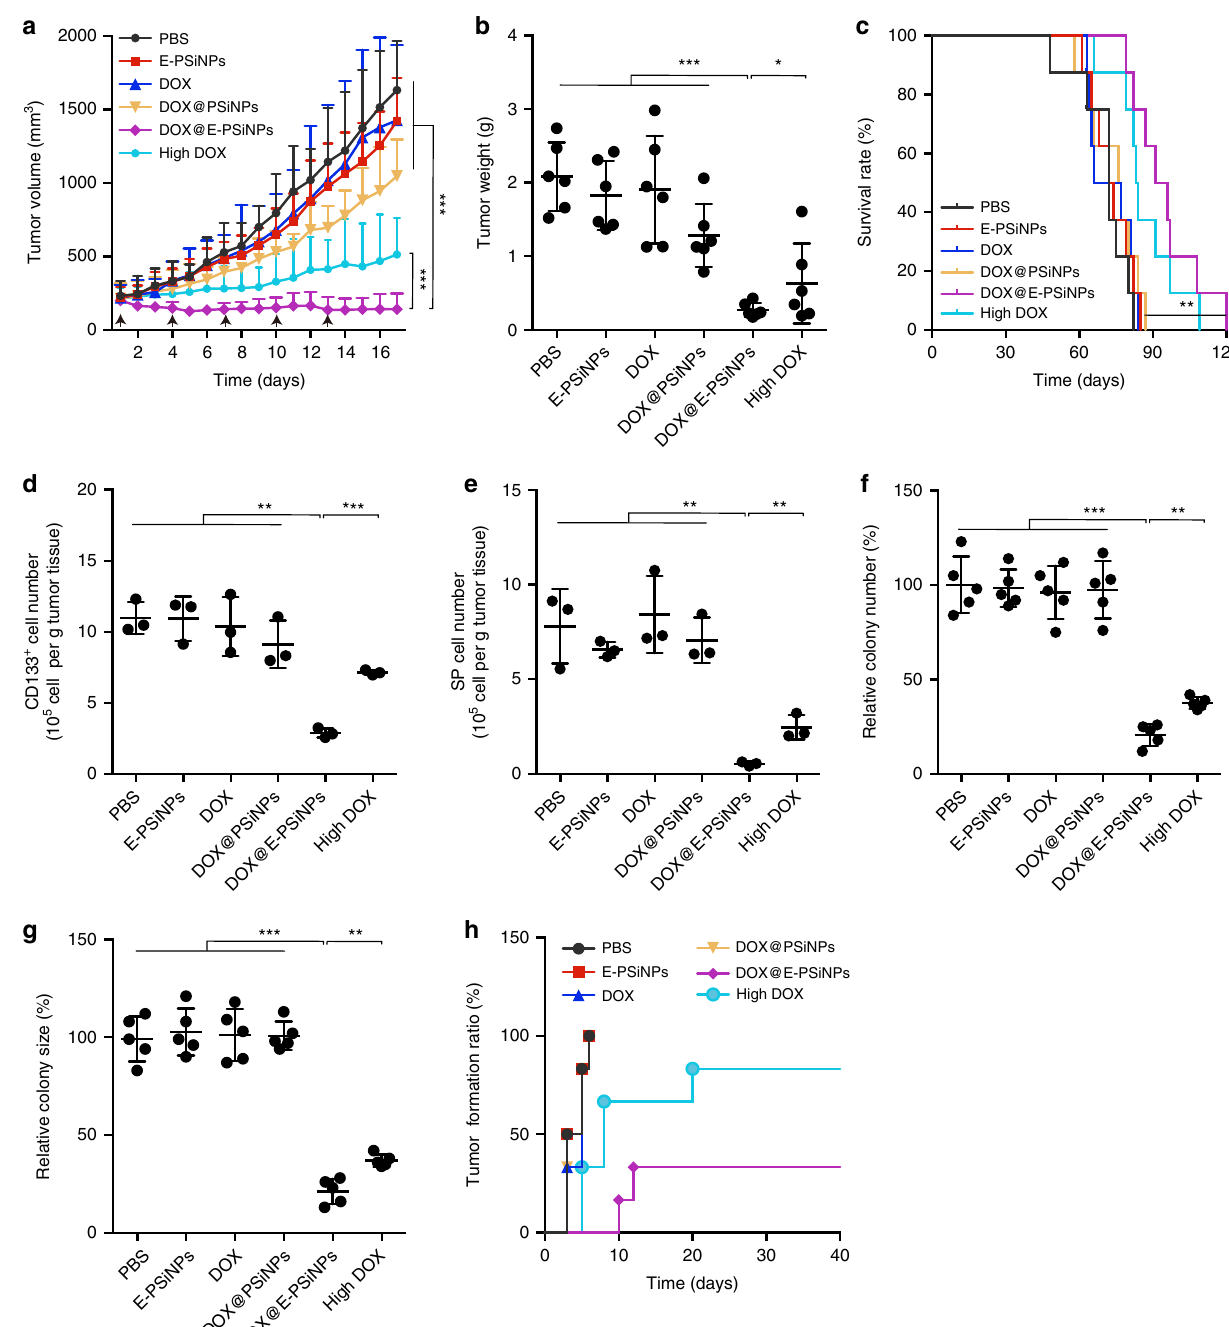
Fig. 7 Anticancer activity of DOX@E-PSiNPs in H22 tumor-bearing mice. a Tumor growth curves of H22 tumor-bearing mice after intravenous injection of PBS, E-PSiNPs, free DOX, DOX@PSiNPs, DOX@E-PSiNPs exocytosed from H22 cells at DOX dosage of 0.5mgkg − 1 , or free DOX at high dosage of 4mgkg − 1 . The arrows indicate the drug injection time. Data were represented as mean±SD ( n = 14). b Weight of tumor tissues at the end of tumor growth inhibition experiments. Data were represented as mean±SD ( n = 6). c Kaplan – Meier survival plot of H22 tumor-bearing mice after intravenous administration of different formulations ( n = 8). d Number of CD133-postive cells in tumor tissues at the end of tumor growth inhibition experiments. e Number of side population cells in GFP-positive tumor cells of GFP-expressing H22 tumor-bearing mice at the end of tumor growth inhibition experiments as above. Data were represented as mean±SD ( n = 3). f , g Relative colony number ( f ) and size ( g ) of tumor spheroids when tumor cells digested from tumor tissues of H22 tumor-bearing mice at the end of tumor growth inhibition experiments were seeded in soft 3D fi brin gels for 5 days. Data were represented as mean±SD ( n = 5). h Tumor formation ratio in BALB/c mice after subcutaneous injection of tumor cells (10 6 cells per mouse) from tumor tissues of H22 tumor-bearing mice after treatment as above. * P <0.05, ** P <0.01, *** P <0.001 (one-way ANOVA with Bonferroni ’ s multiple comparisons test for a , b , and d – g and log-rank test for c ). Source data